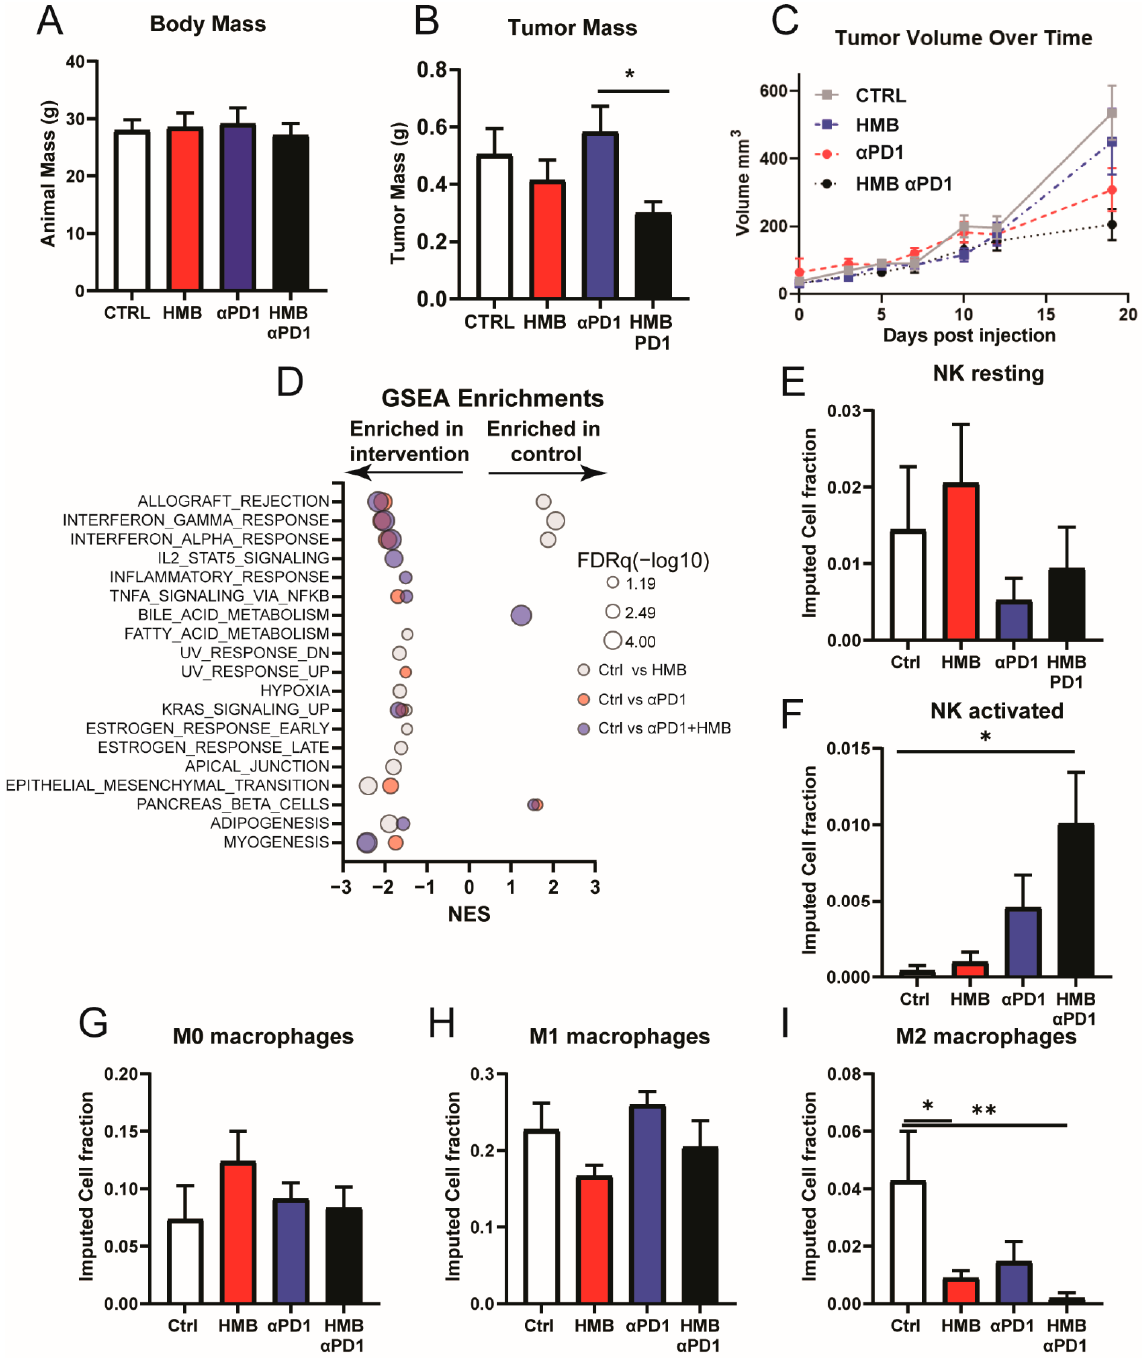
Figure 3. ( A ) Body mass of mice supplemented with or without HMB and treated with or without anti-PD1 immunother- apy at study termination ( n = 12–13/group). ( B ) Tumor mass in mice supplemented with or without HMB and treated with or without anti-PD1 immunotherapy at study termination ( n = 12–13/group). ( C ) Tumor volume over time of mice supplemented with or without HMB and treated with or without anti-PD1 immunotherapy ( n = 12–13/group). ( D – I ) Transcriptomic analysis of tumors from control and anti-PD1-treated mice with or without HMB supplementation ( n = 6–7/group). ( C ) Significant GSEA enrichments from Hallmark gene sets resulting from comparing control vs. HMB (gray), control vs. PD1 (red), and control vs. PD1 + HMB (blue) mice. FDRq is denoted by the bubble size. ( D – H ) CIBERSORTx digital cytometry-imputed cell fractions: ( D ) resting NK cells, ( E ) activated NK cells, ( F ) M0 macrophages, ( G ) M1-like macrophages, and ( H ) M2-like macrophages. All data are presented as means ± SEM. Differences are considered significant if p < 0.05 (* p < 0.05, ** p <